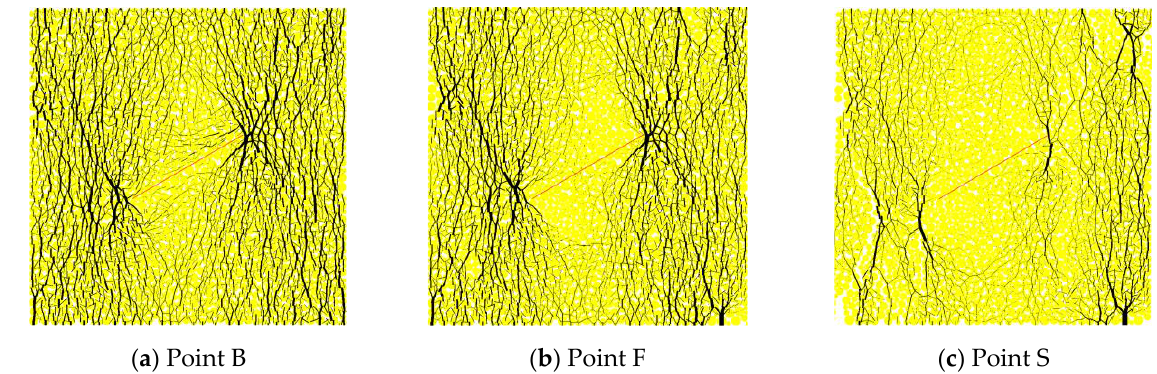
Figure 11. Evolution of the parameters of the joint system with increasing axial strain ( 𝛽 =30°).